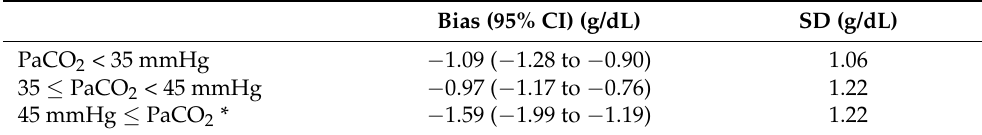
Table 2. Accuracy of SpHb by PaCO 2